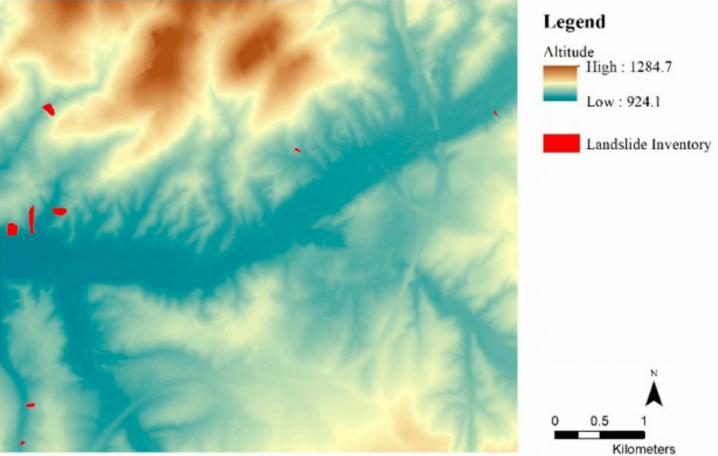
Figure 3. The elevation map and the manually delineated landslides (red polygons).